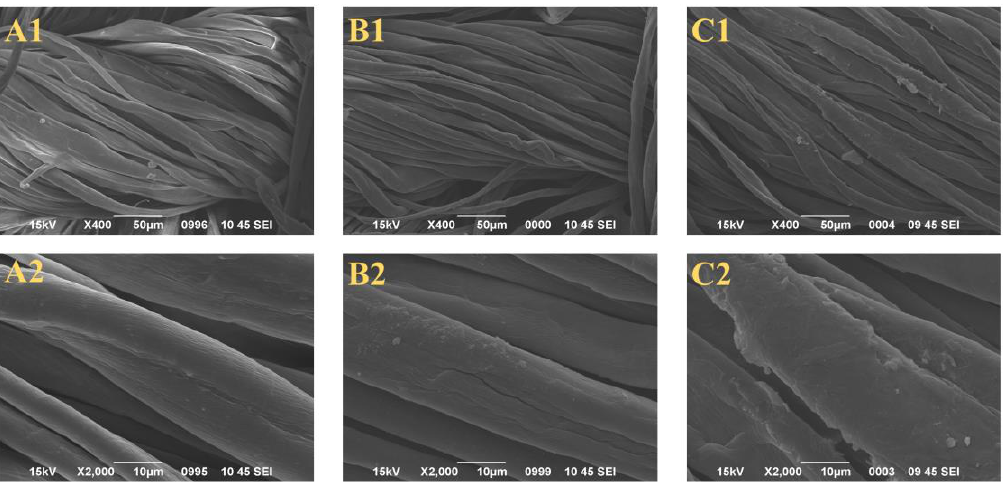
× 400 and × 2000) of untreated and treated cotton fabrics: Control ( A1 , A2 ), Figure 2. SEM micrographs (×400 and ×2000) of untreated and treated cotton fabrics: Control ( A1 , Figure 2. SEM micrographs ( PAP-200 ( B1 , B2 ), PAPBTCA-200 ( C1 , C2